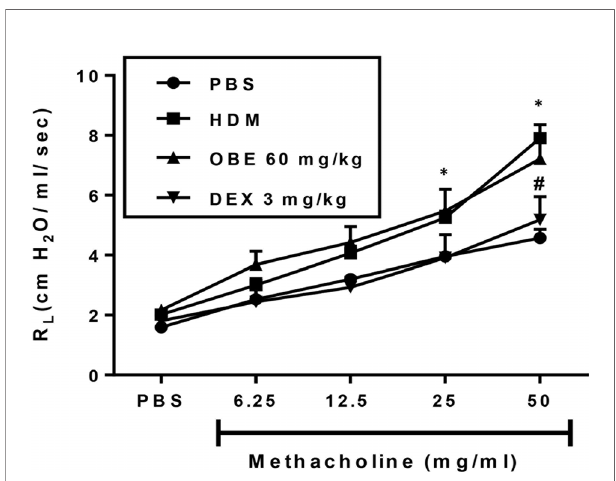
FIGURE 8 | Effect of OBE treatment on HDM-induced AHR to inhaled methacholine. HDM challenged mice demonstrated signi fi cant AHR compared to the control group at doses 25 and 50 mg/kg of methacholine. Treatment with dexamethasone (3 mg/kg; i.p.) signi fi cantly reduced the HDM- induced AHR. However, treatment with OBE (60 mg/kg; i.p.) did not signi fi cantly reduce the average R L in comparison with the HDM-challenged/ vehicle-treated group at any of the doses of methacholine tested (P > 0.05). Data are expressed as mean ± SEM ( n = 6 – 13). *P < 0.05 vs PBS group, # P < 0.05 for HDM group vs DEX